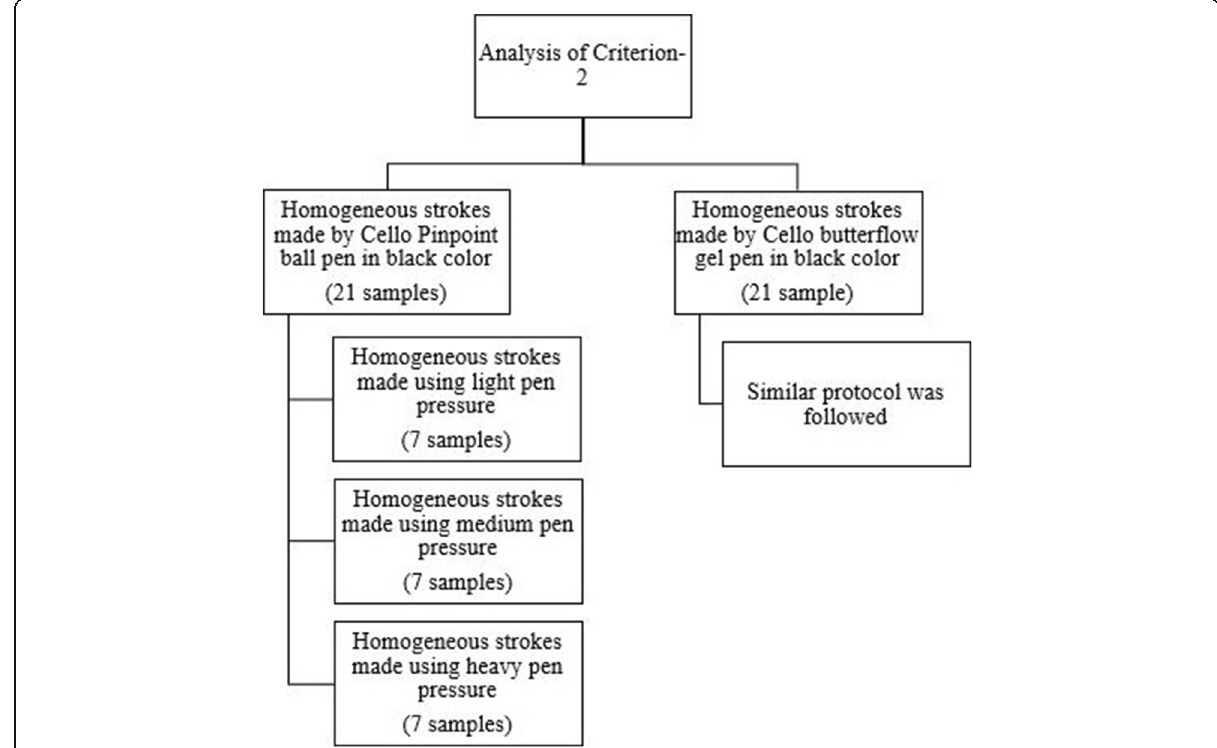
Fig. 3 Graphical representation illustrating the protocol of producing samples for criterion